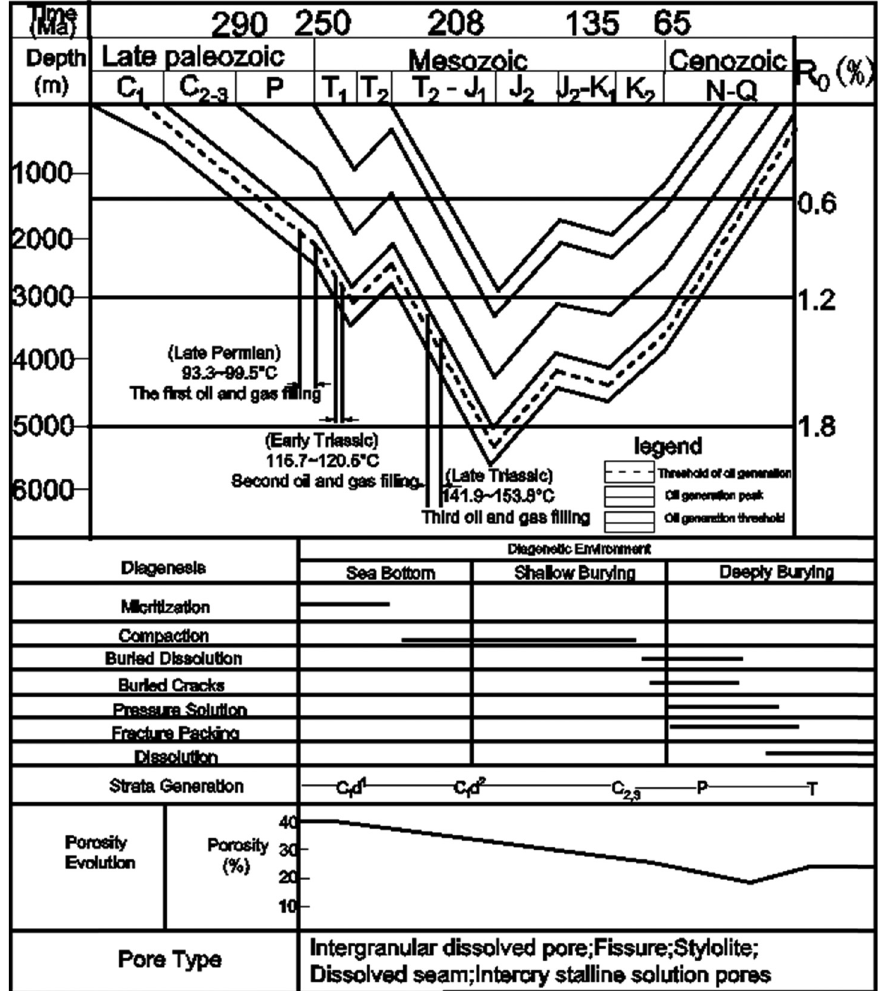
Figure 9: Burial historical diagram showing the determination of hydrocarbon gas charging time and reservoir evolution for the central Hu